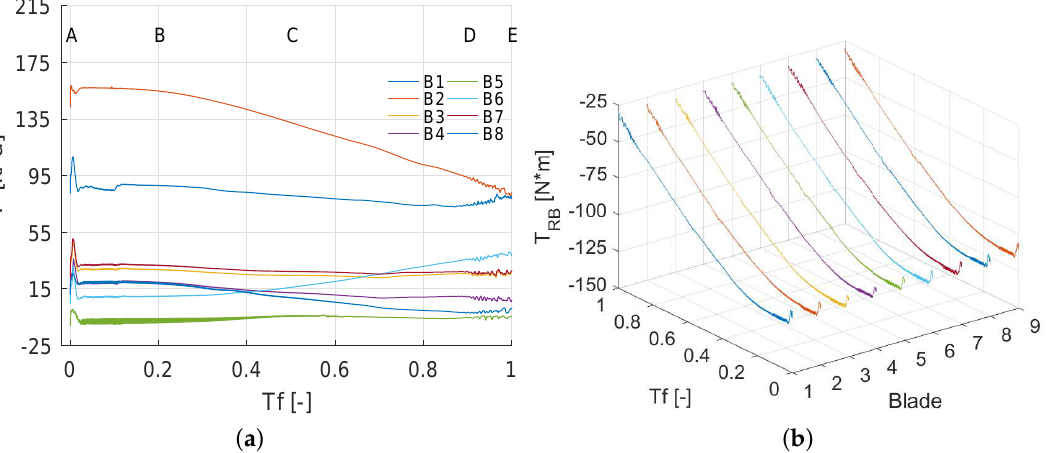
Figure 17. ( a ) Evolution of pressure at the considered points on the blade1; and ( b ) evolution of torque of runner blades.